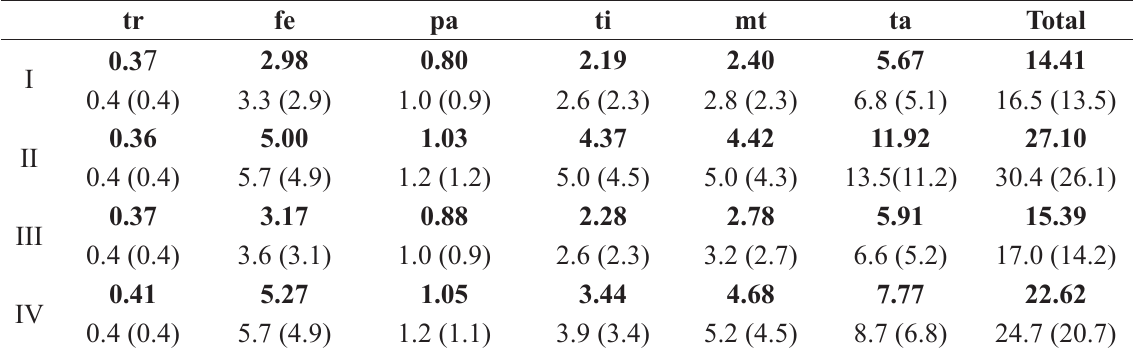
Table 1. Leiolima iberica gen. et sp. nov. Leg lengths of male holotype (in bold type) and average leg lengths of males (n = 4) and females (in parentheses, n =